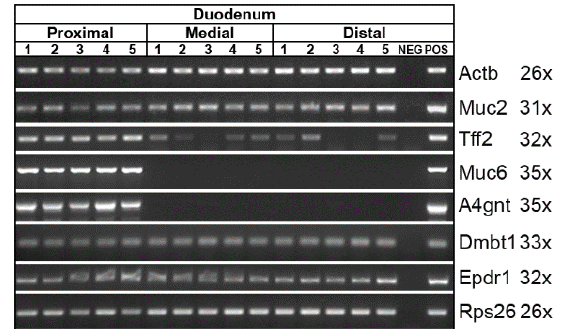
Figure 7. RT-PCR analysis. Tff1 , Tff2 , Tff3 , Gkn2 , Muc2 , Muc5ac , Muc6 , A4gnt , Fcgbp , Dmbt1 , Gast , Pdx1 , and Epdr1 expression in the gastric corpus and antrum, respectively, as well as in the pancreas. The number of amplification cycles is given in parentheses (if different for stomach and pancreas). As controls, expression of Actb and Rps26 , respectively, was monitored.